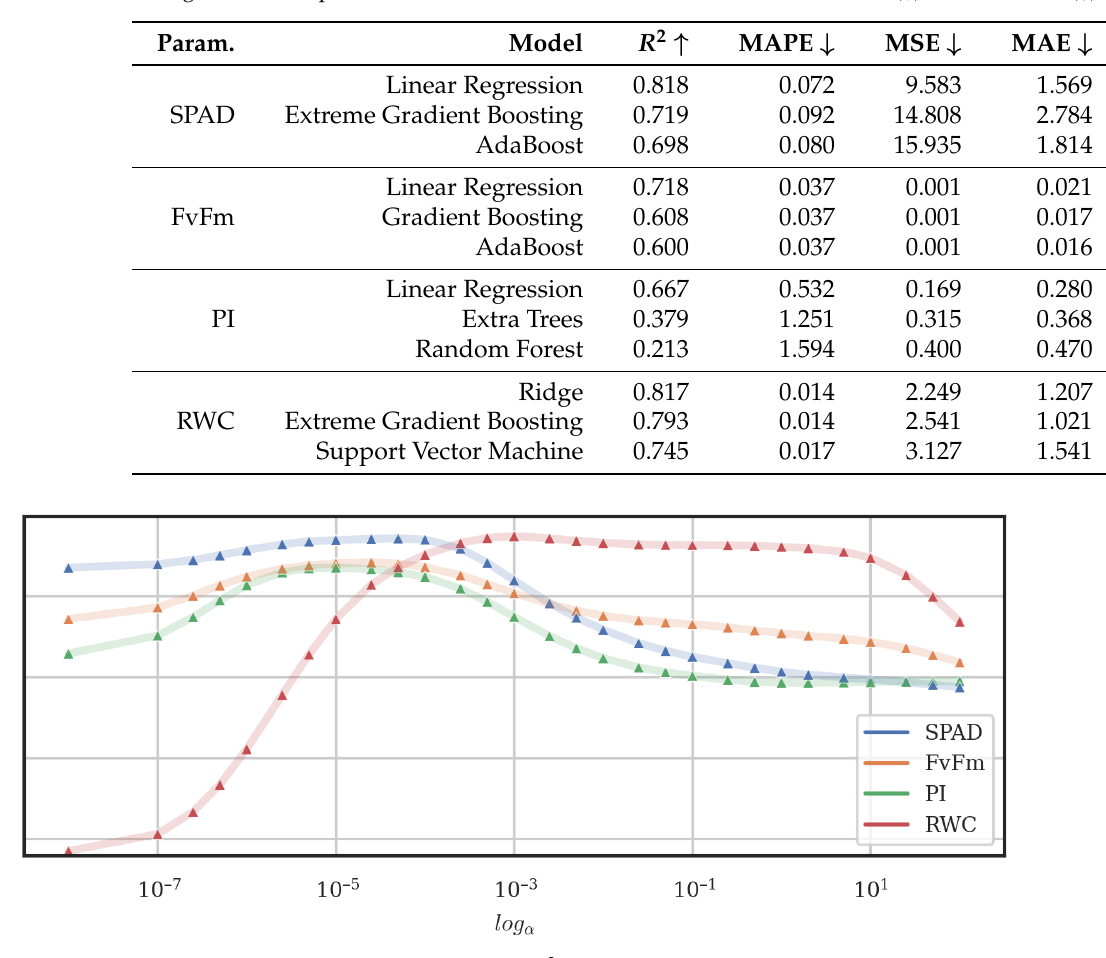
Figure 5. The Ridge regression results ( R 2 over the test sets for each parameter) obtained using a range of the α hyperparameter